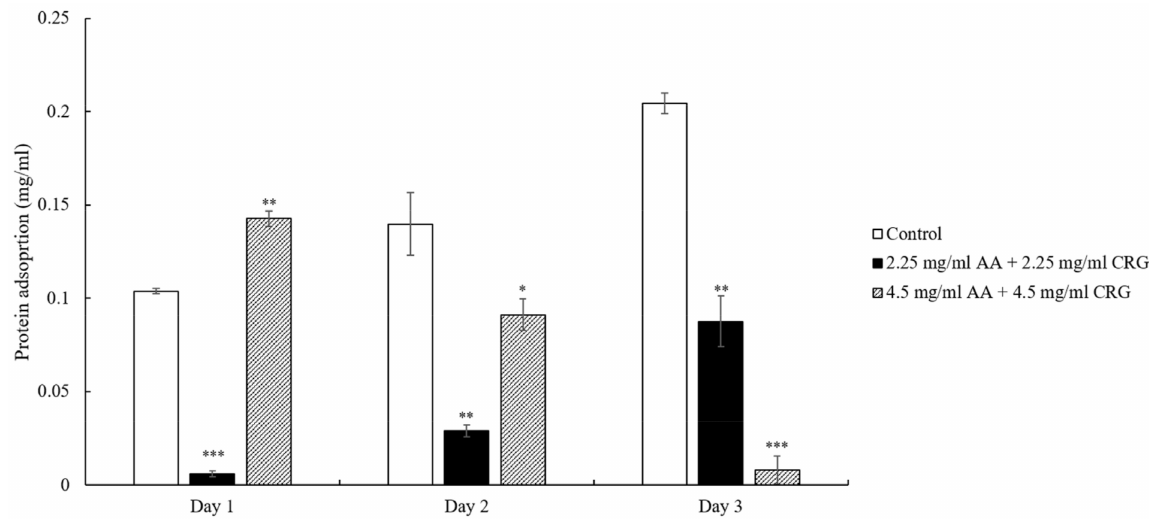
Figure 3. The concentration of total protein adsorption on the ortho-k lens when being immersed in artificial tear solution (control, white bars), 2.25 mg/mL (black bars) or 4.5 mg/mL (grey slashed bars) polysaccharides-containing artificial tear solution. * p < 0.05, ** p < 0.01, and *** p < 0.001 when comparing protein adsorption amount in polysaccharides-containing artificial tear solution versus in control on the same day. Error bars represented standard deviation.